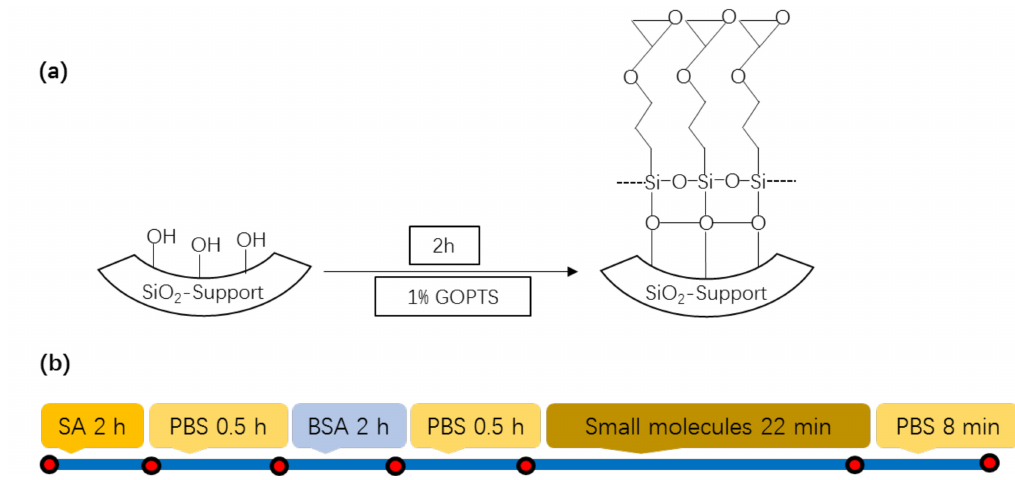
Figure 2. ( a ) Schematic illustration of surface functionalization of microbubble surface with epoxy groups; ( b ) Flow diagram of experimental processes for small biomolecule binding to surface-immobilized